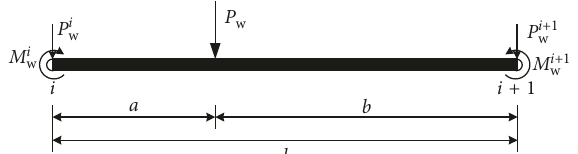
Figure 2: Allocation of wheel-rail force on the beam element of